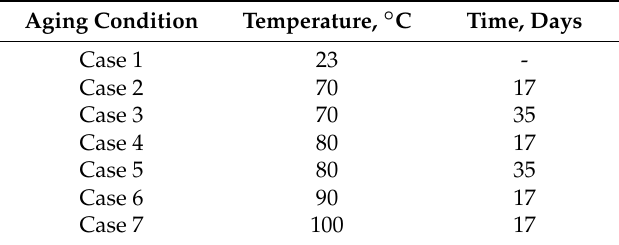
Table 1. Accelerated aging conditions of swelling